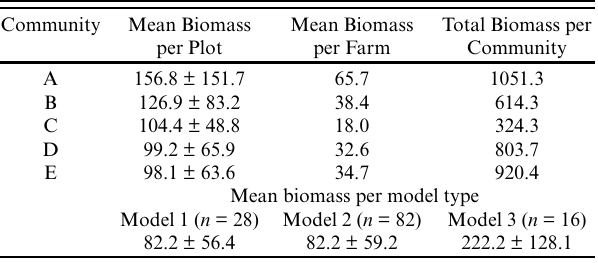
Table 3 . Mean (± standard deviation [SD]) aboveground biomass in planted trees. Values at the plot scale (kg/100 m²), the total farm scale (Mg/farm), and the community scale (Mg/community) are shown. Also shown is mean (± SD) aboveground biomass in planted trees in each agroforestry model type (Mg/model type; n = individuals per model type across all